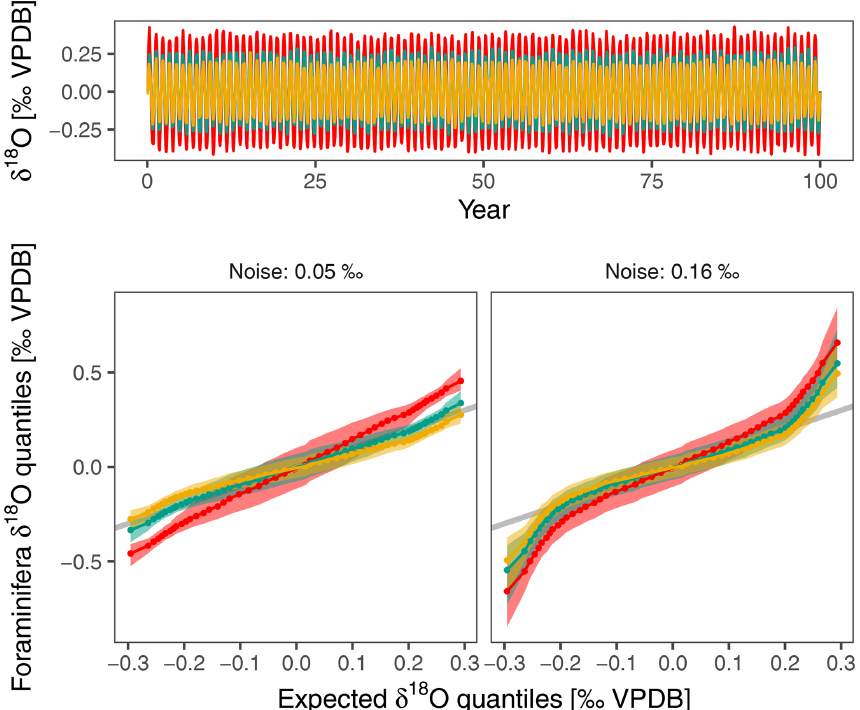
Figure 7. Excess δ 18 O variability mostly affects tails of δ 18 O distribution within individual foraminifera. This simple simulation shows the effect of excess variability on capability to reconstruct changes in the amplitude of the seasonal cycle. The input consists of a synthetic δ 18 O eq time series with a seasonal amplitude of 0.25‰ that is not atypical of conditions in the central equatorial Pacific. The monthly time series is constructed using a sine wave with 0.02‰ random noise and is sampled 100 times at random to crudely represent planktonic foraminifera δ 18 O. This is an optimistic scenario as fewer foraminifera are usually used for IFA. The Q–Q plots show the effect of a change in the seasonal amplitude of δ 18 O eq for a scenario that only accounts for analytical noise (assumed to be 0.05‰) and for another that incorporates the excess variability found in this study. Higher noise levels affect the tails of the distribution and make it harder to detect changes in the